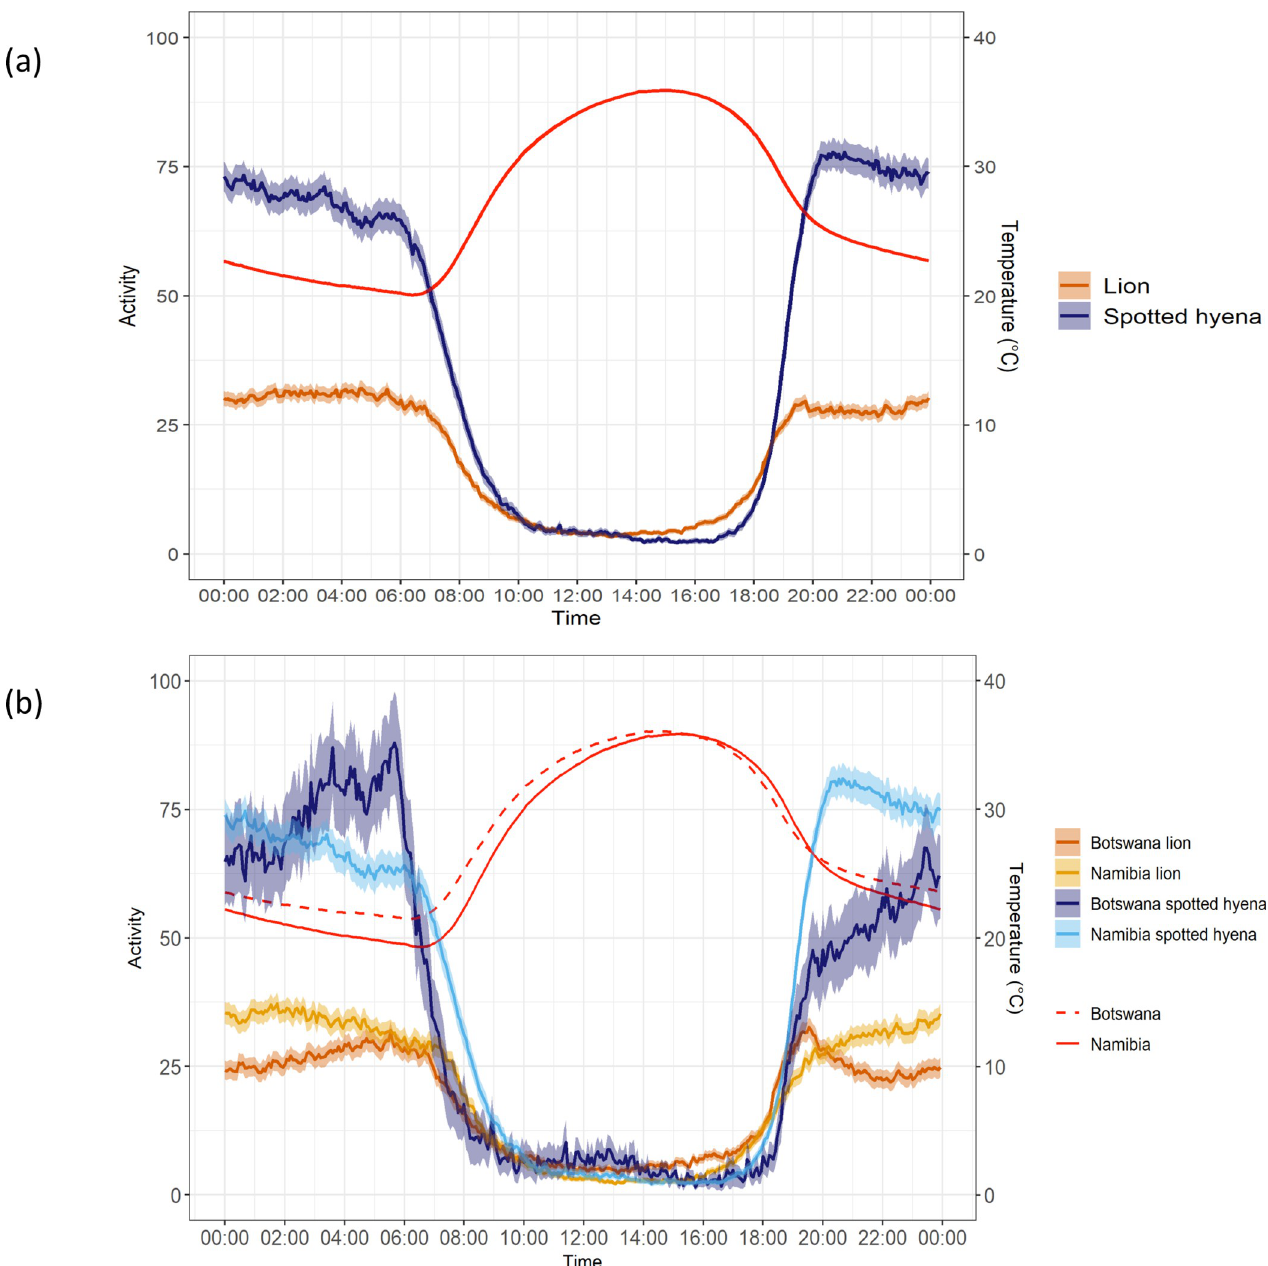
Fig 5. Mean activity of lions and spotted hyenas. Activity rates over the 24-hour cycle of (a) lions and spotted hyenas, and (b) lions and spotted hyenas from the Etosha National Park, Namibia and the Chobe National Park, Linyanti Conservancy, and the Okavango Delta a , Botswana. Means are represented by solid lines with 95% confidence intervals the shaded bars. The red lines indicate the average temperatures (˚C) over the 24-hour cycle. a No spotted hyenas were collared from the Okavango Delta , Botswana